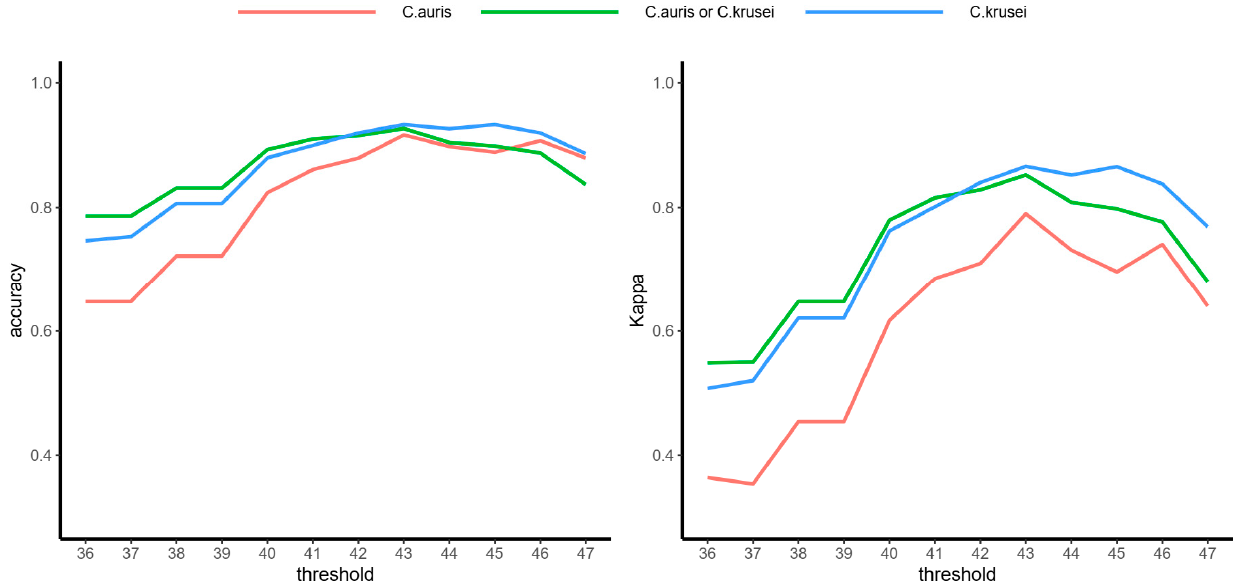
Figure 2. Accuracy and kappa values for C. auris and C. krusei mixed samples. Accuracy is the percentage of correctly classified samples out of all samples. Cohen’s kappa is the normalized accuracy at the baseline of a random guess. It is more useful when dealing with imbalanced data. The closer these two values were to 1.0, the better the model’s performance.